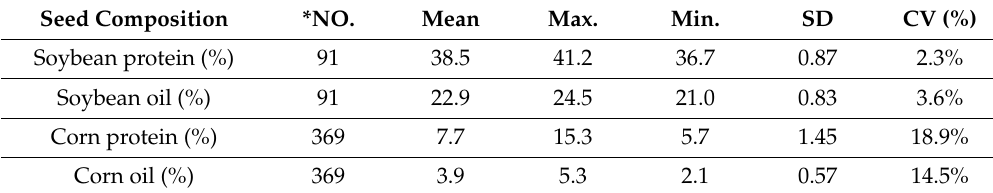
Table 1. Summary statistics of soybean and corn seed composition datasets. Seed Composition *NO. Mean Max. Min. SD CV (%) Soybean protein (%) 91 Corn protein (%) Corn oil (%)